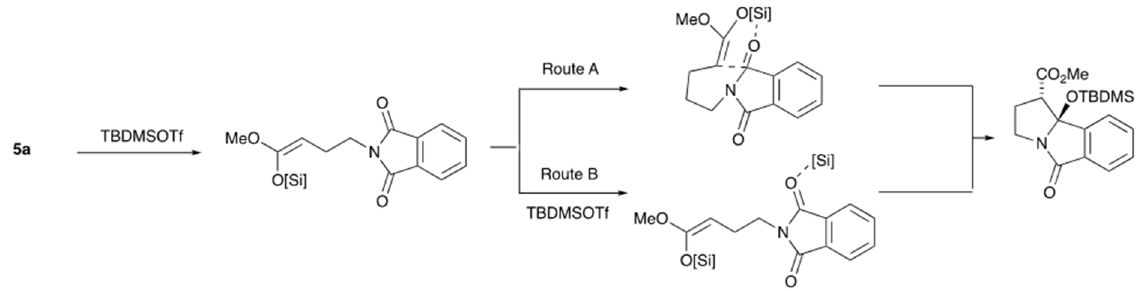
Figure 1. Possible mechanism for aldol ring closure.